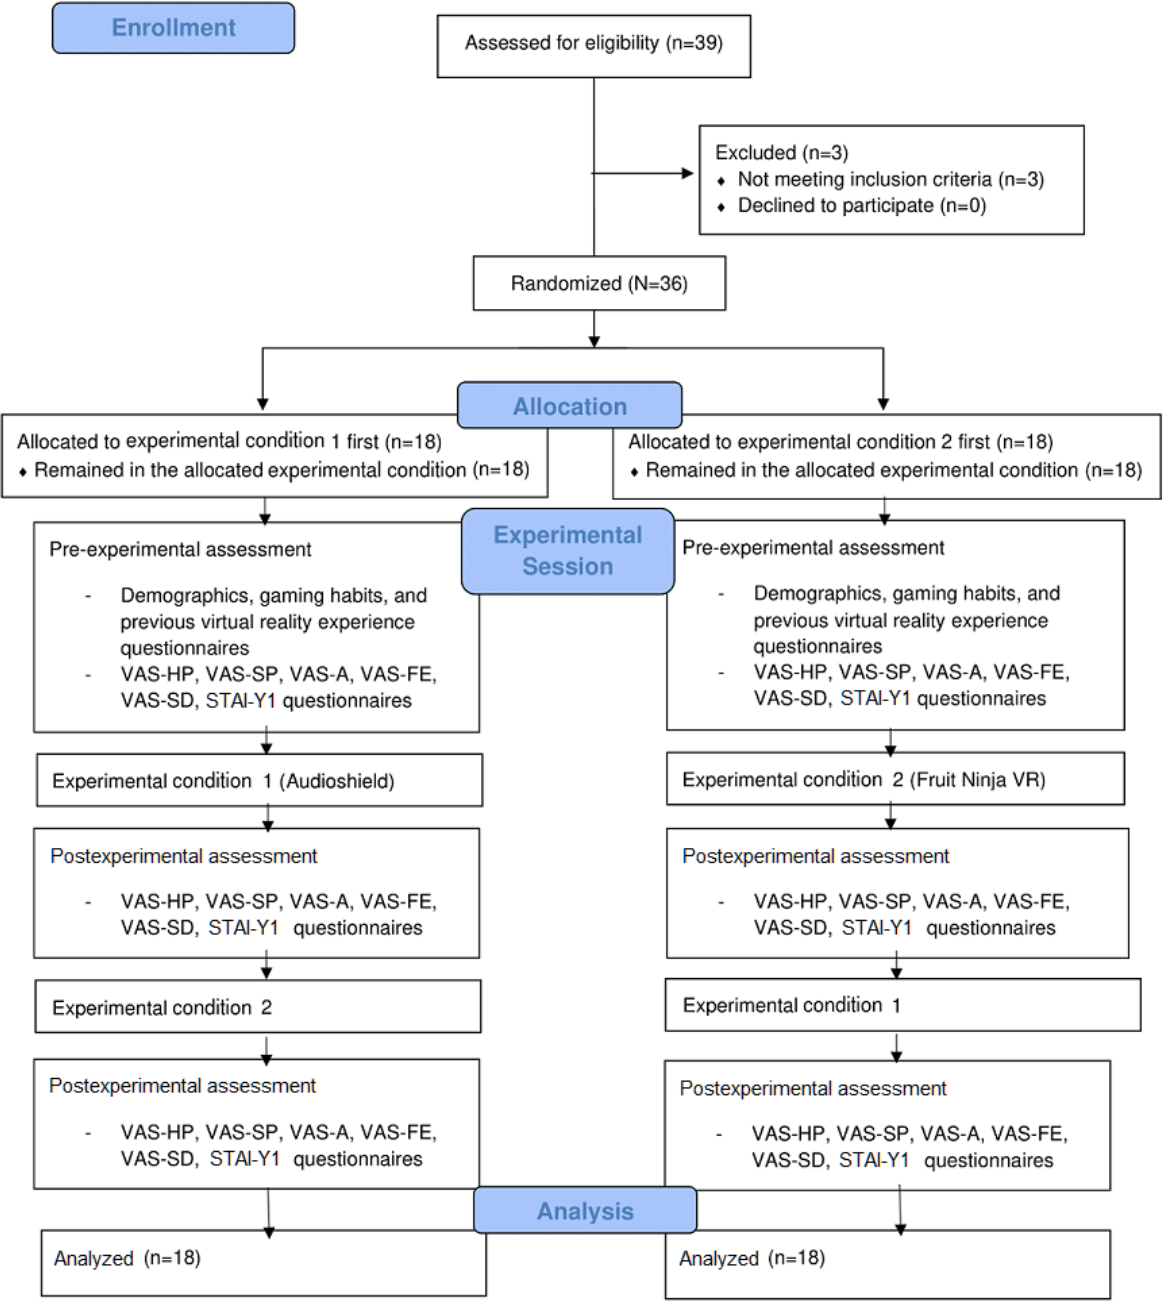
Figure 1. Flowchart of the study procedure. STAI-Y1: State-Trait Anxiety Inventory, Form-Y1; VAS-A: Visual Analogue Scale-anxiety; VAS-FE: Visual Analogue Scale-fear; VAS-HP: Visual Analogue Scale-happiness; VAS-SD: Visual Analogue Scale-sadness; and VAS-SP: Visual Analogue